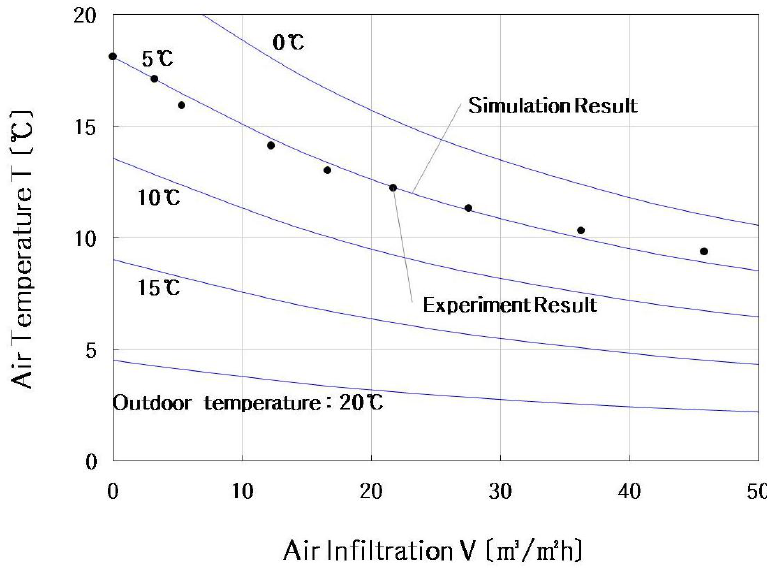
Figure 7. Effect of temperature increase on air infiltration.